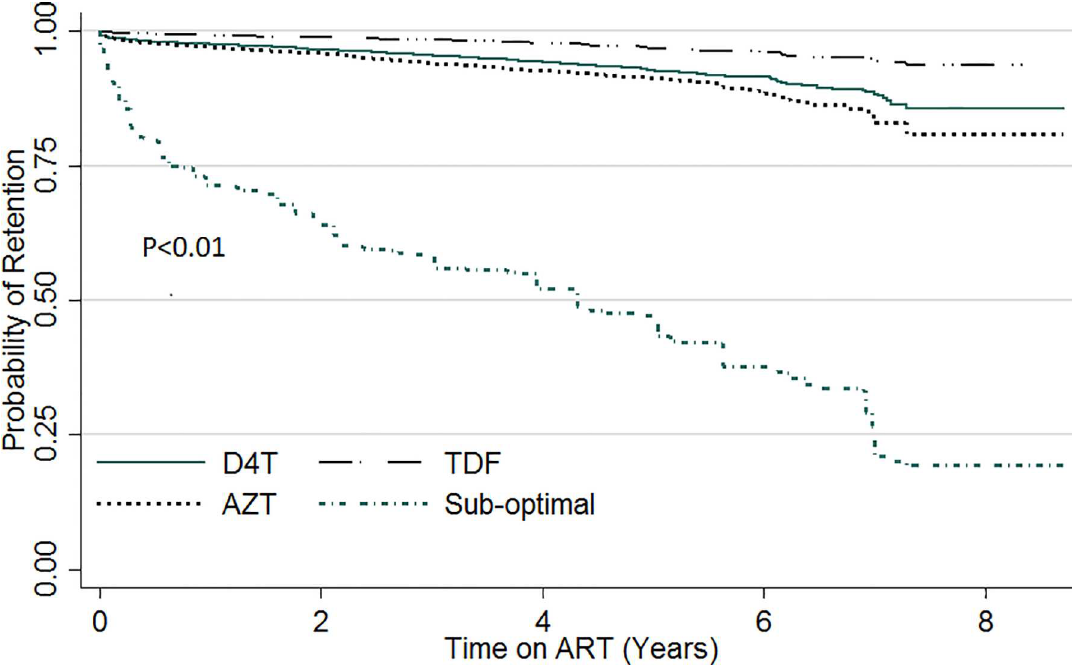
Fig 5. ART retention stratified by baseline regimen.